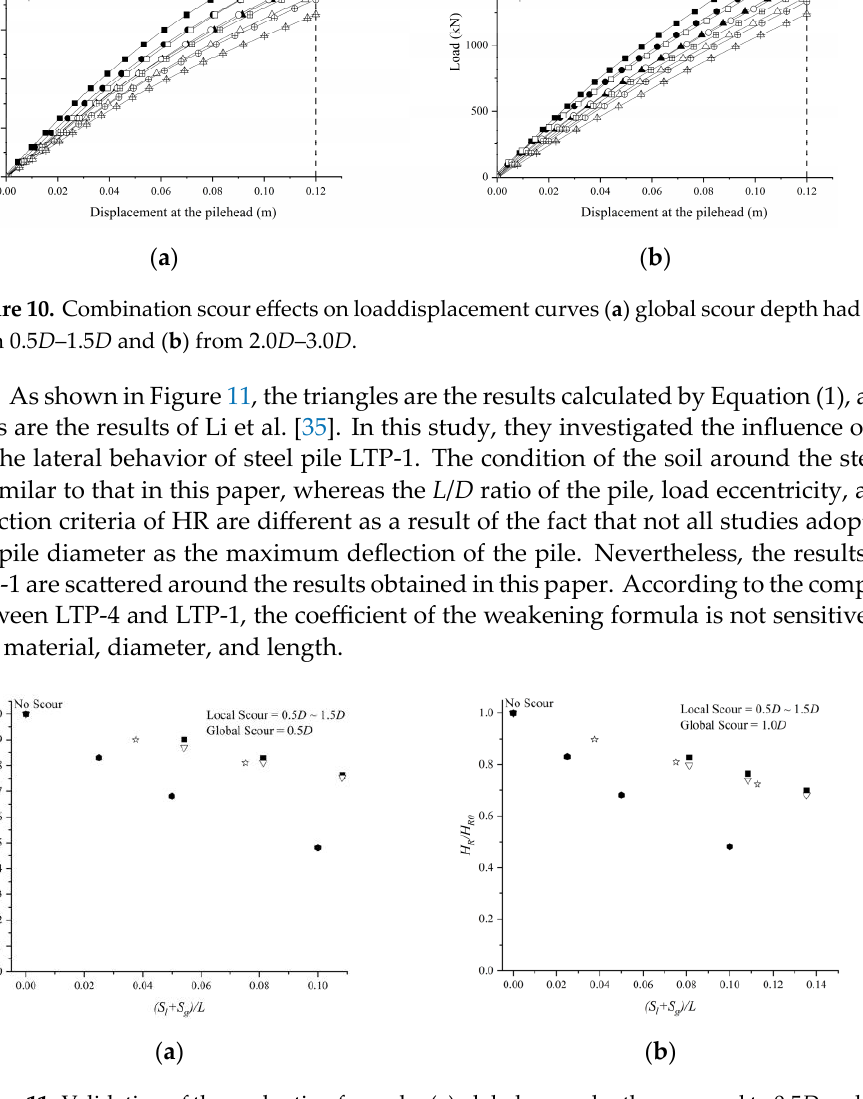
Figure 11. Validation of the evaluation formula. ( a ) global scour depth was equal to 0.5 D and ( b ) was equal to 1.0 D . In both cases the following legend applies: ( n —Numerical results, ▽ —Equation